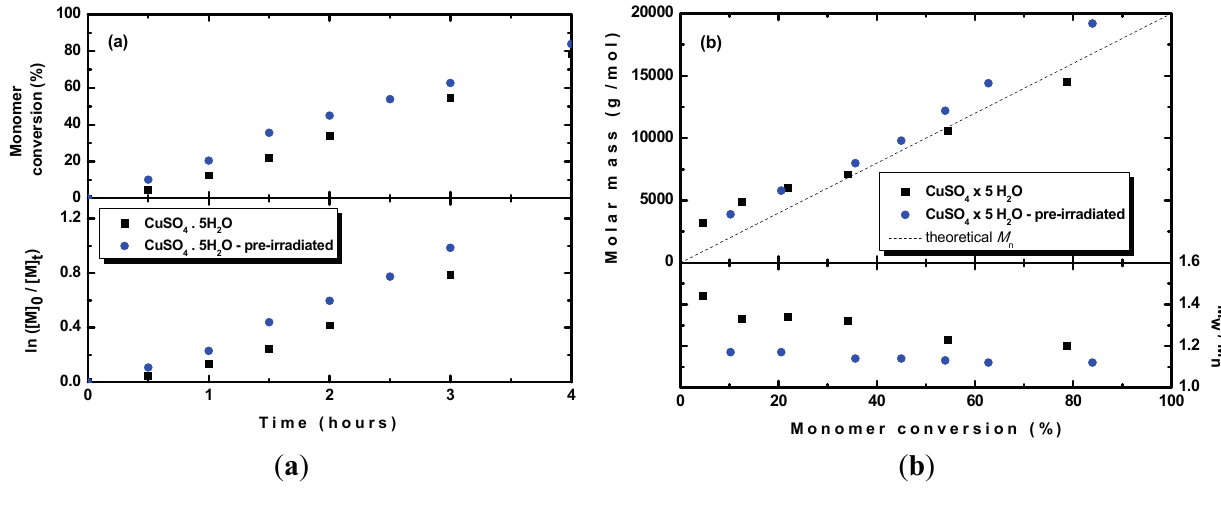
Figure 7. ( a ) Kinetic plots and ( b ) evolution of the molar mass and M w / M n with the conversion of MMA during photoRDRP using CuSO 4 ·5H 2 O/TPMA complex. MMA was added either before irradiation or after 1 h of pre-irradiation of the solvent containing catalyst, ligand and initiator. Experimental conditions: photoRDRP, MMA/BPN/Cu II /TPMA = 200/1/0.04/0.16, irradiation at λ > 350 nm; in all